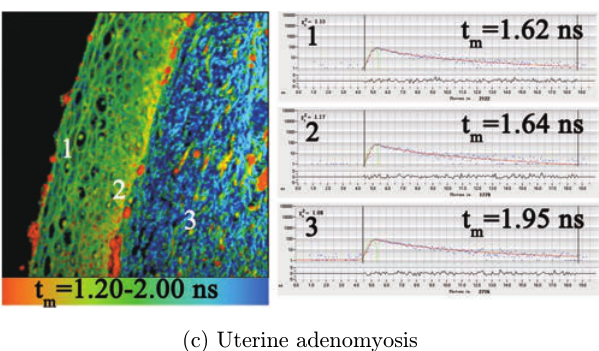
Fig. 3. FLIM images and di®erent mean °uorescence lifetime decay curves at di®erent areas (marked as 1, 2 and 3) of healthy cervix tissues from (a) normal (Patient No. 1), (b) uterine leiomyomas (Patient No. 9) and (c) uterine adenomyosis (Pa- tient No. 22) patients. Area 1 and 2 was in the super¯cial and basal layers, respectively. Area 3 was in the basement. Scale bar: 50 (cid:1) m. The FLIM images were detected by the single- channel TCSPC